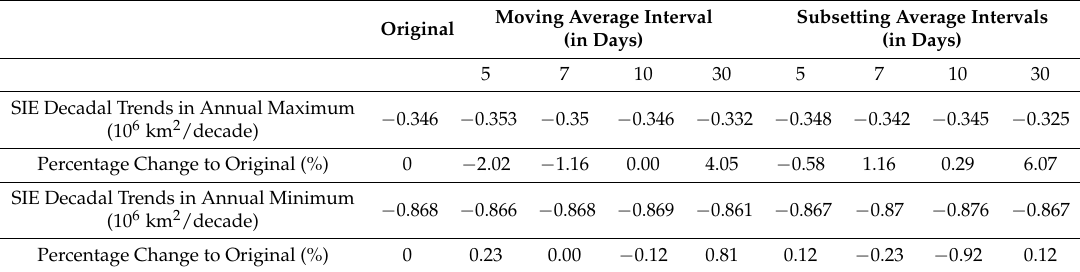
Table 1. SIE decadal linear trends (10 6 km 2 /decade) from different averaging methods and intervals for the period of 1979–2015, along with their percentage changes relative to those of the original daily SIE time series. Moving Average Interval Subsetting Average Intervals Original (in Days) (in Days)